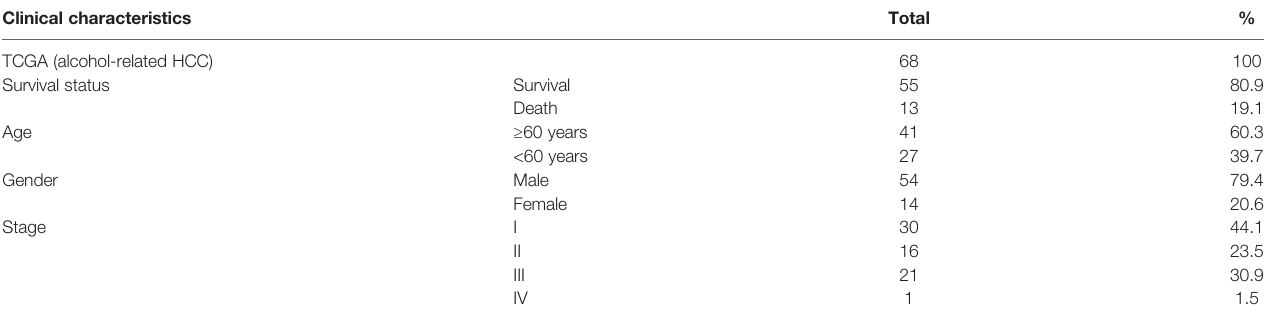
TABLE 1 | Clinical information of alcohol-related HCC from